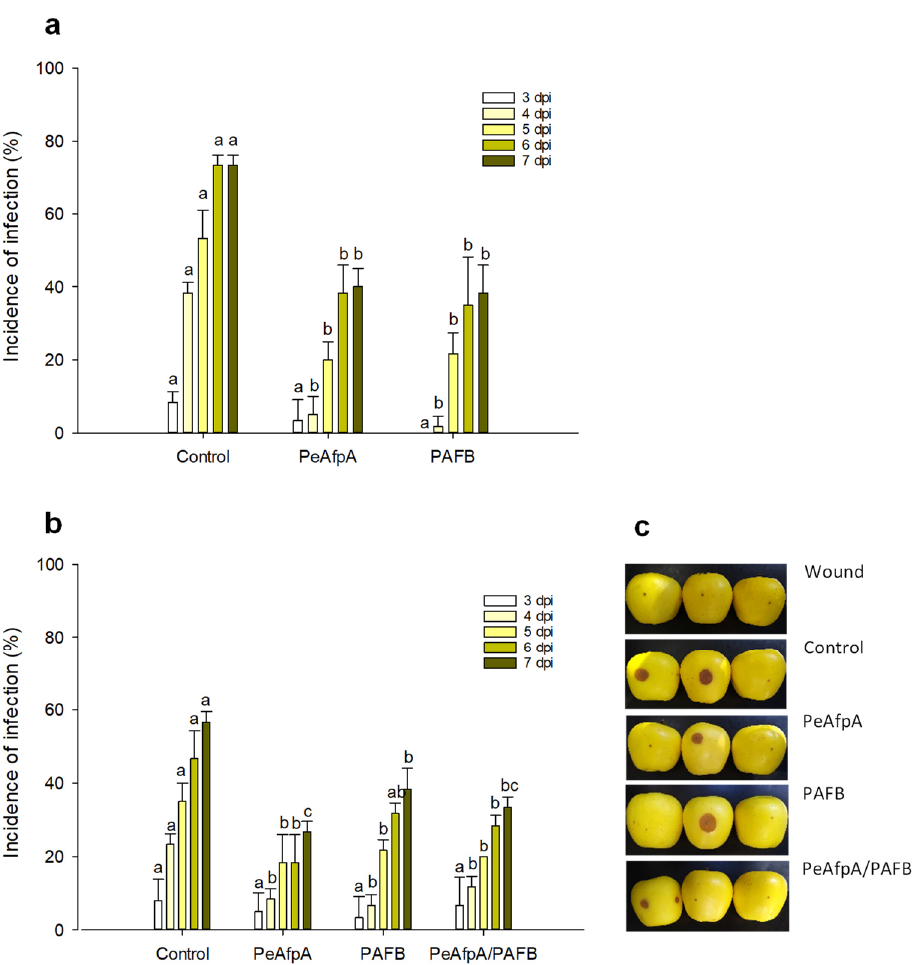
Figure 4. Effect of different antifungal proteins on the infection of apple fruits cv Golden by P. expansum . ( a ) Effect of PeAfpA and PAFB on the infection of apple fruits. ( b ) Effect of PeAfpA, PAFB and PeAfpA/PAFB on the infection of apple fruits. Apple fruits were inoculated with 10 4 conidia/mL of P. expansum either alone (Control) or in the presence of 100 µg/mL of AFPs (corresponding to 15 µM PeAfpA and 16 µM PAFB). Bars show the mean values of the percentage of infected wounds and standard deviation (SD) of three replicates of five apples at 3, 4, 5, 6, and 7 dpi. Letters show significant differences among the treatments at each independent day (One-way ANOVA and Tukey’s HSD test, p < 0.05). ( c ) Representative images of treated apples of ( b ) with AFPs and combinations at 7 dpi.